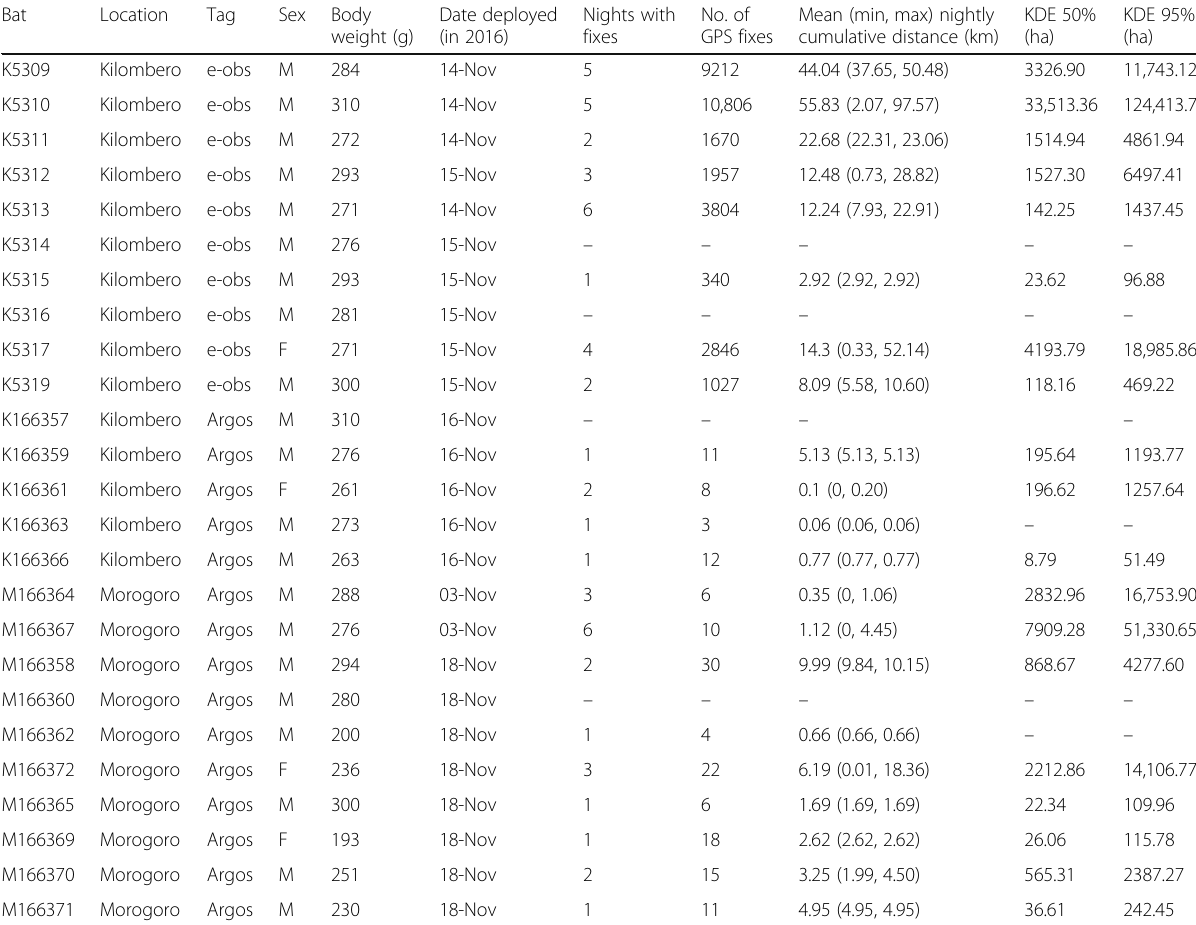
Table 1 Deployment summary, nights tracked, cumulative flight distances, and kernel density estimates of habitat utilization of tracked bats